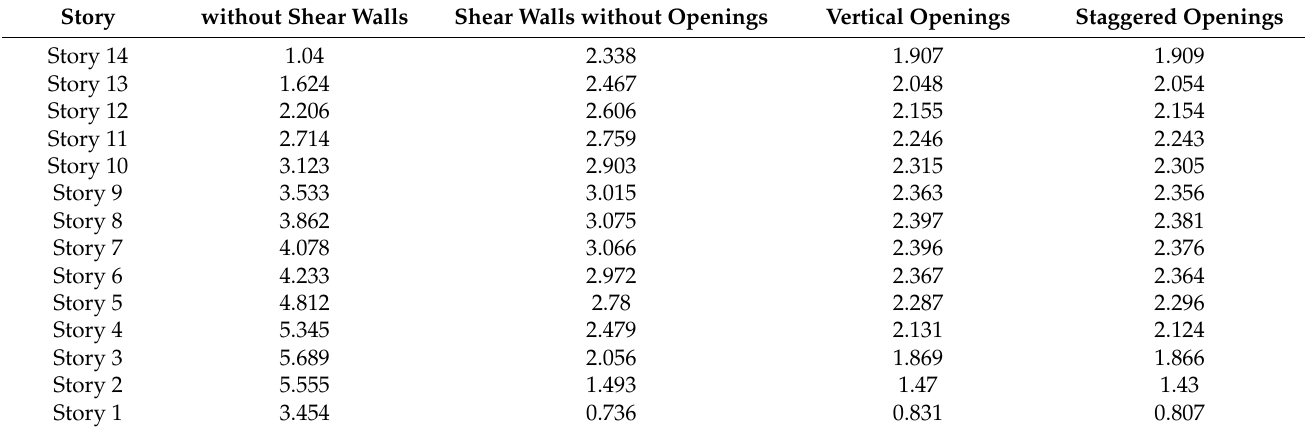
2.381 mm for the building ’ s vertical and staggered opening in X-direction, respectively; with vertical and staggered Y-direction openings. Table 14. Comparison of the story drift, time history analysis, X-direction (mm).